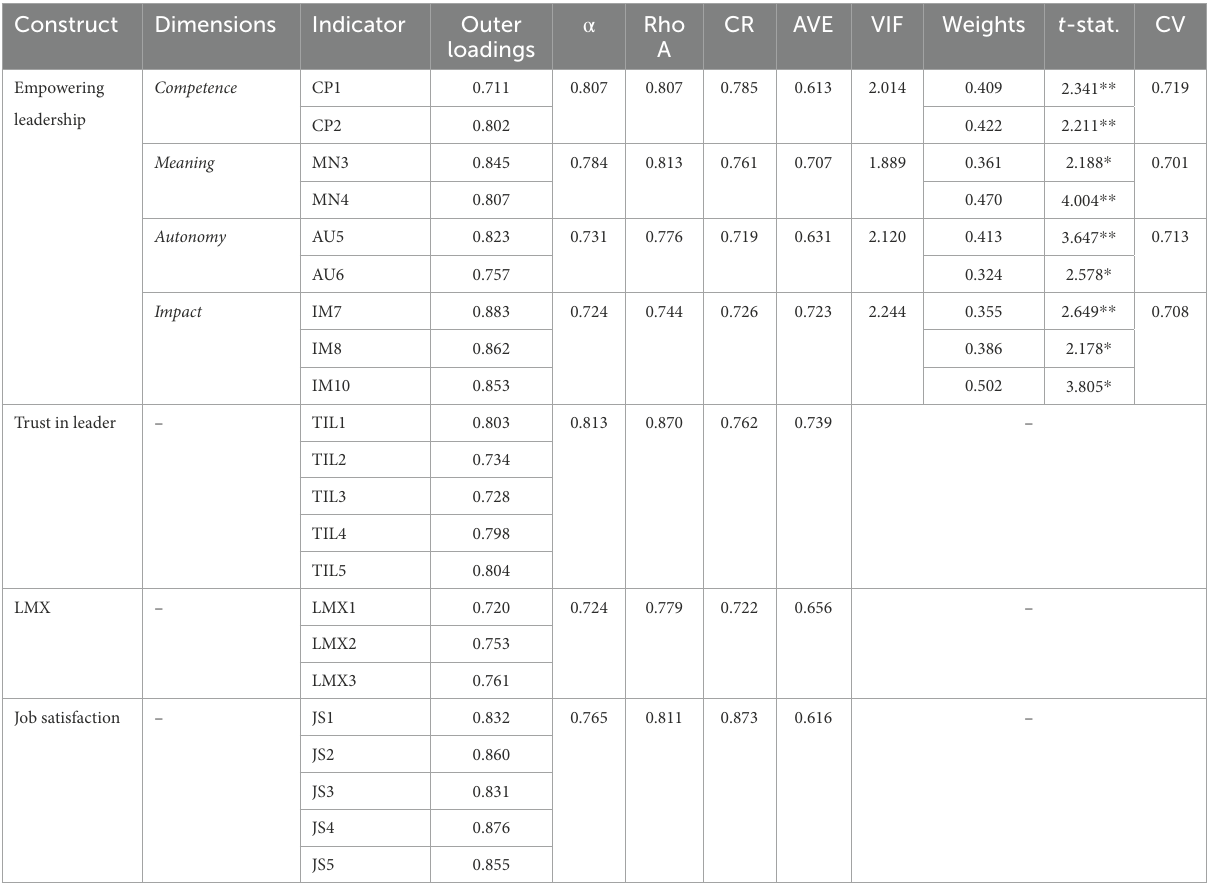
TABLE 1 Measurement model